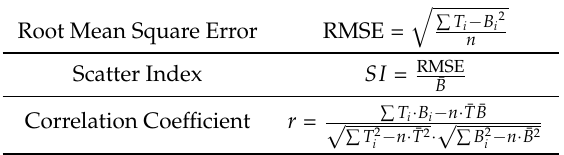
Table 1. Mathematical equations to compute the error metrics.